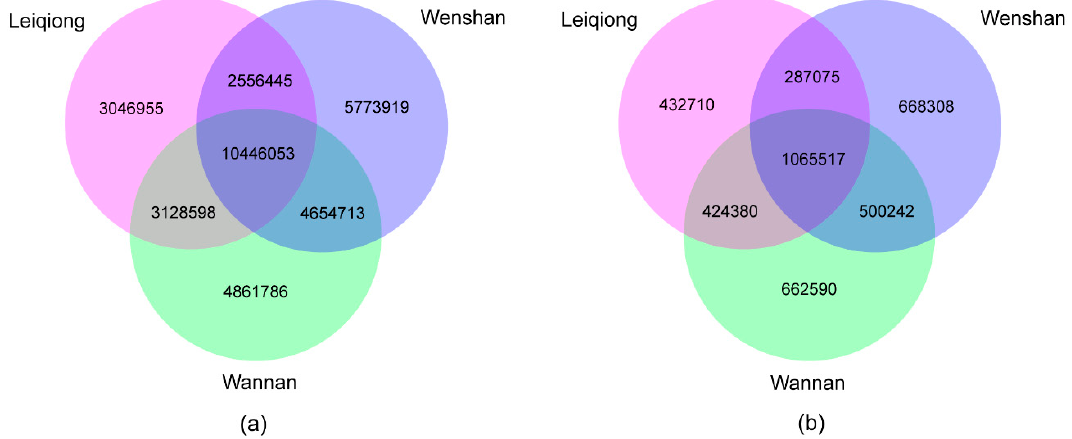
Figure 2. Venn diagram describes overlap and unique SNPs / InDels between the three breeds (LQ, WN, WS). The numbers show specific SNPs / InDels for each breed or overlapping SNPs / InDels between any two breeds or among three breeds. ( a ) The identified shared and specific SNPs for each breed. ( b ) The identified shared and specific InDels for each breed.